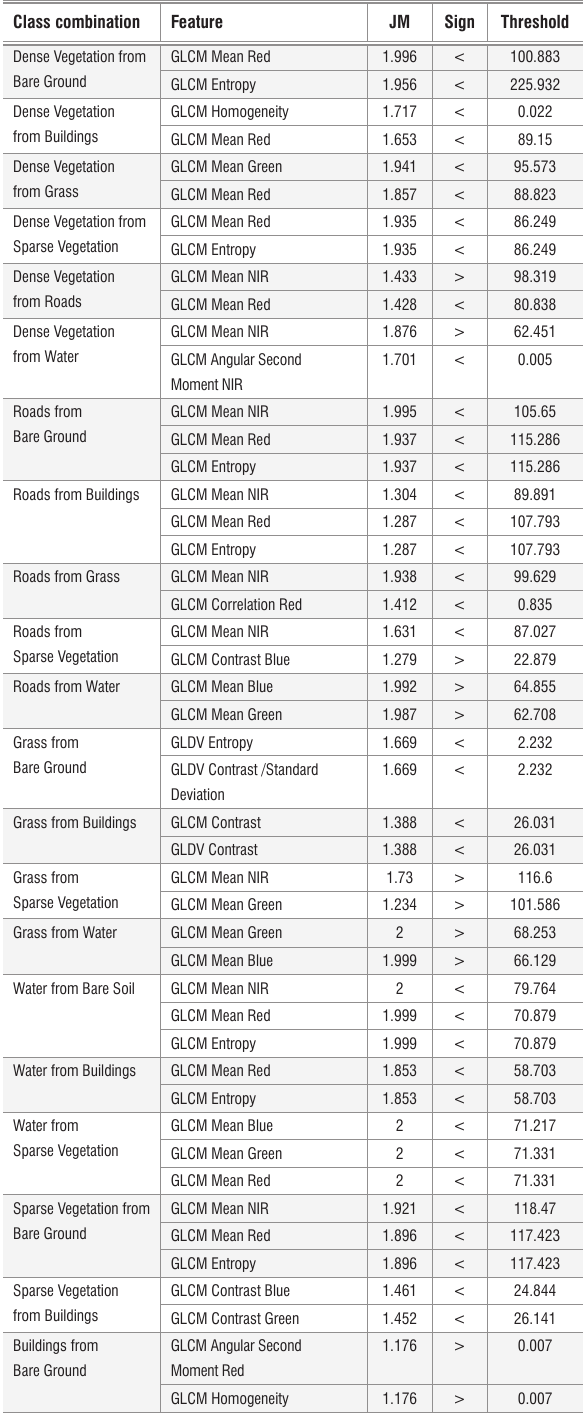
Table 3: Separability of land-use/land-cover classes using GLCM textural features